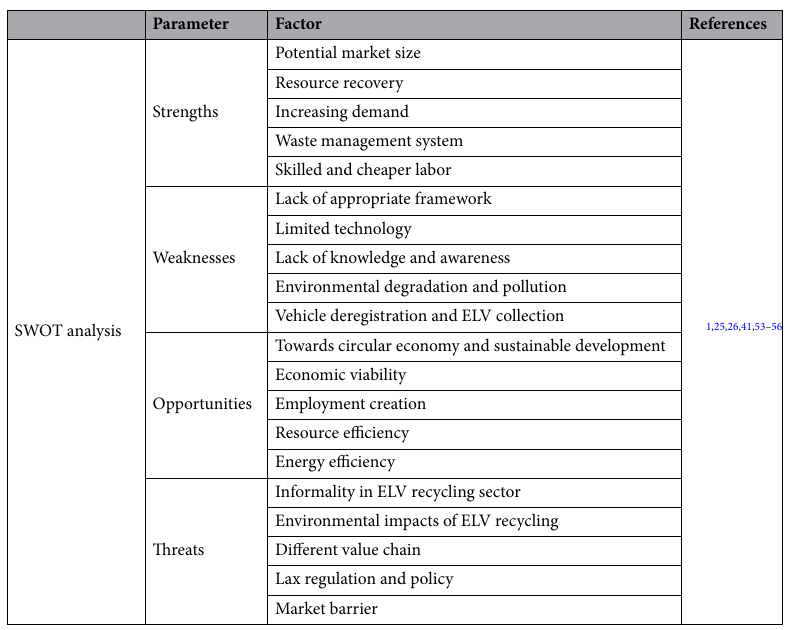
Table 3. The questionnaire items for the SWOT analysis.